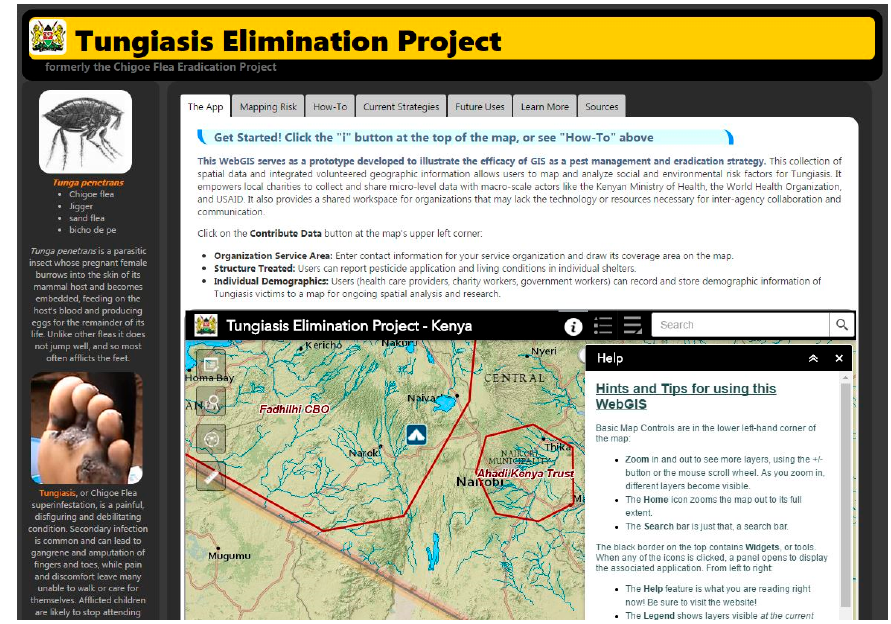
Figure 1. Screenshot of the Tungiasis Elimination Project Application Website.